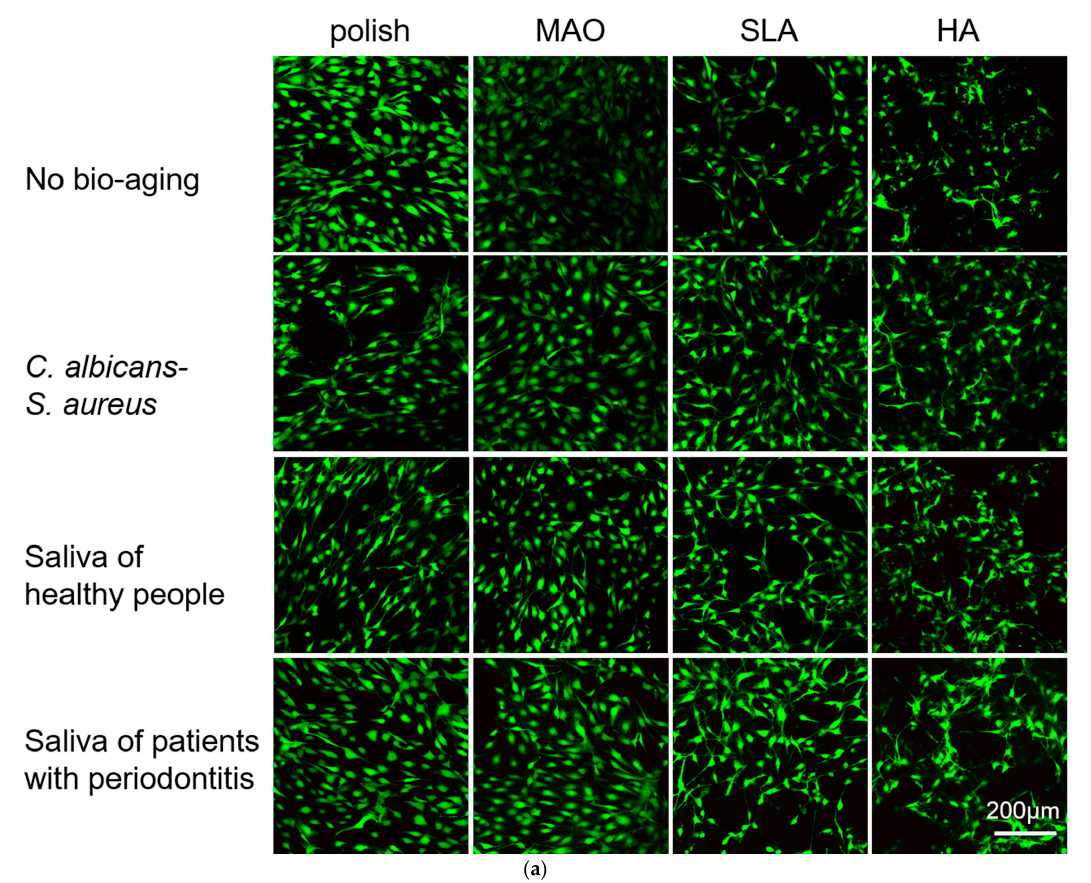
Figure 3. ( a ) and ( b ) The adhesion of HGEs was measured by laser confocal microscopy at 24 h and 48 h, respectively; ( c ) and ( d ) The metabolic activity of HGEs was measured by a CCK-8 test at 24 h and 48 h, respectively. n = 5 (* p < 0.05, ** p < 0.01).